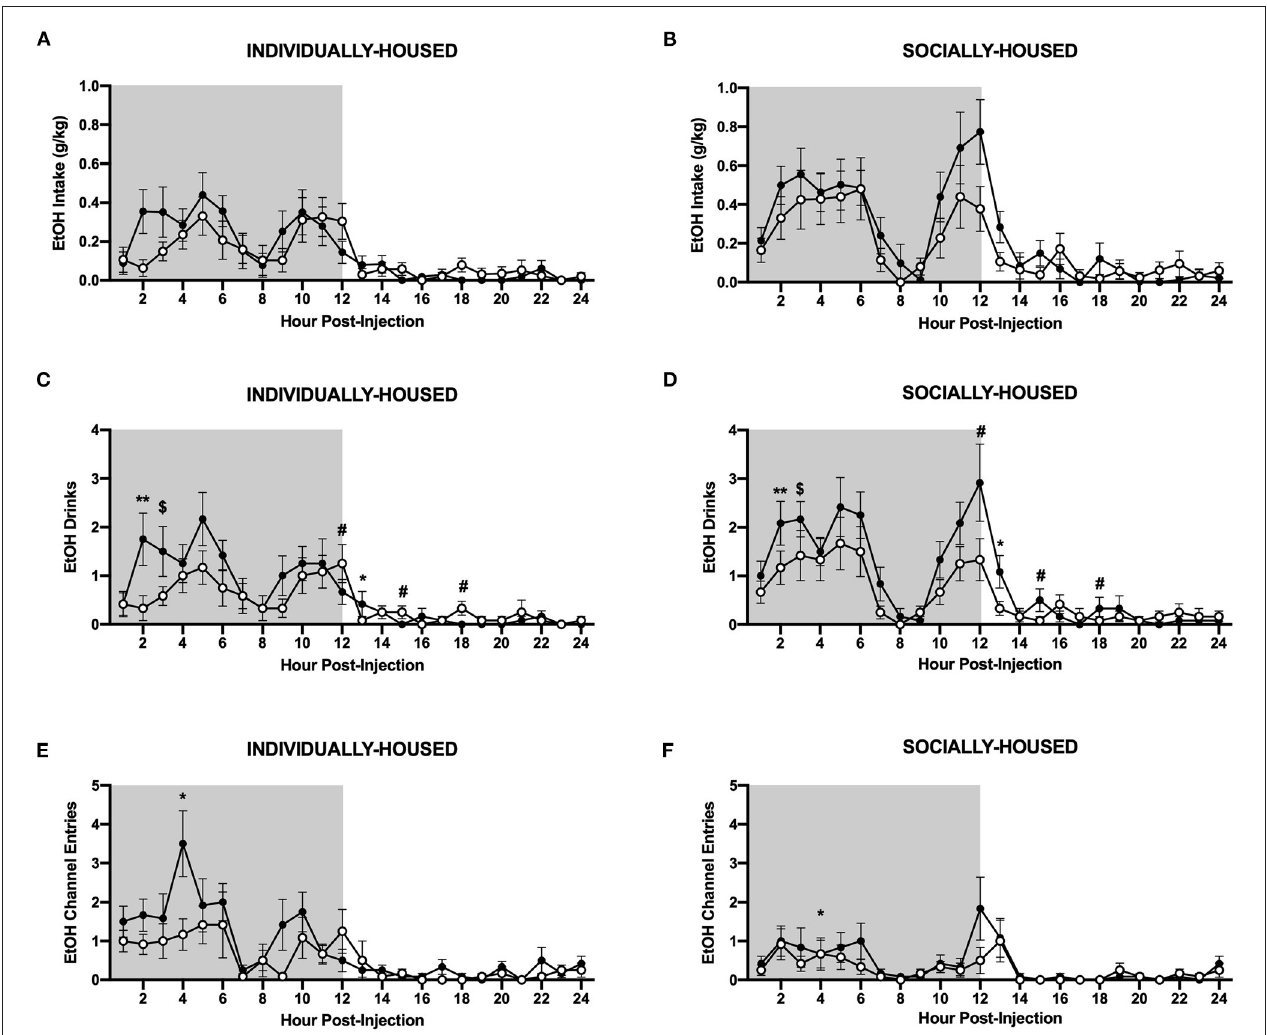
FIGURE 9 | Hourly ethanol data post-CRFR1 antagonism. (A) Ethanol intake in g/kg for individually-housed mice. (B) Ethanol intake in g/kg for socially-housed mice. (C) Number of ethanol drinks for individually-housed mice. (D) Number of ethanol drinks for socially-housed mice. (F) Ethanol channel entries for individually-housed mice. (E) Ethanol channel entries for socially-housed mice. As observed in the cumulative 24 h data, no effect of CRFR1 antagonism on g/kg ethanol intake was observed, but this treatment did cause a time-dependent decrease in the number of ethanol drinks in both housing conditions. Additionally, CRFR1 antagonism caused a trend-level decrease in non-consummatory channel entries, and this decrease is likely driven by the individually-housed group. $ p = 0.05, * p < 0.05, ** p < 0.01, compared to vehicle-treated mice across housing condition. # p < 0.05 represents interaction between housing condition and CRFR1 antagonism at specific timepoint. Data represented as mean ± SEM. n = 12/group. Shaded regions are representative of the dark